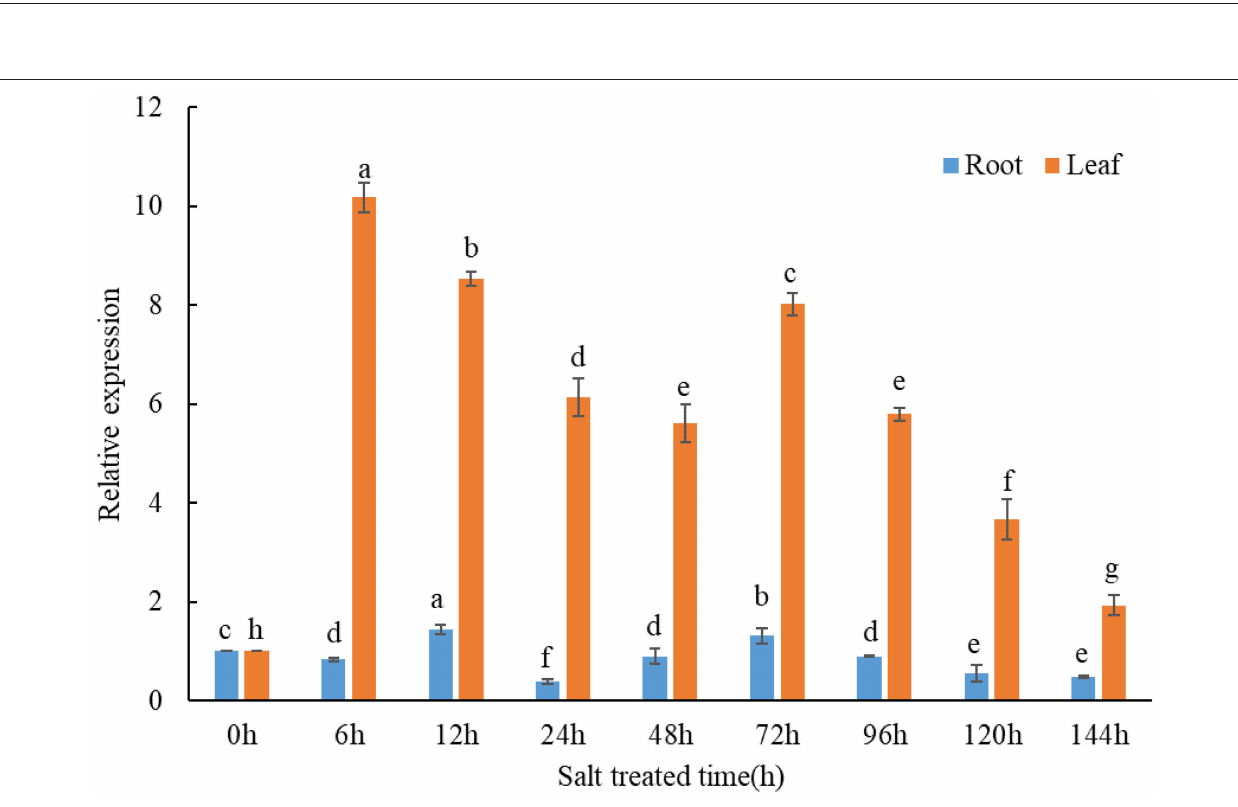
Frontiers in Plant Science |